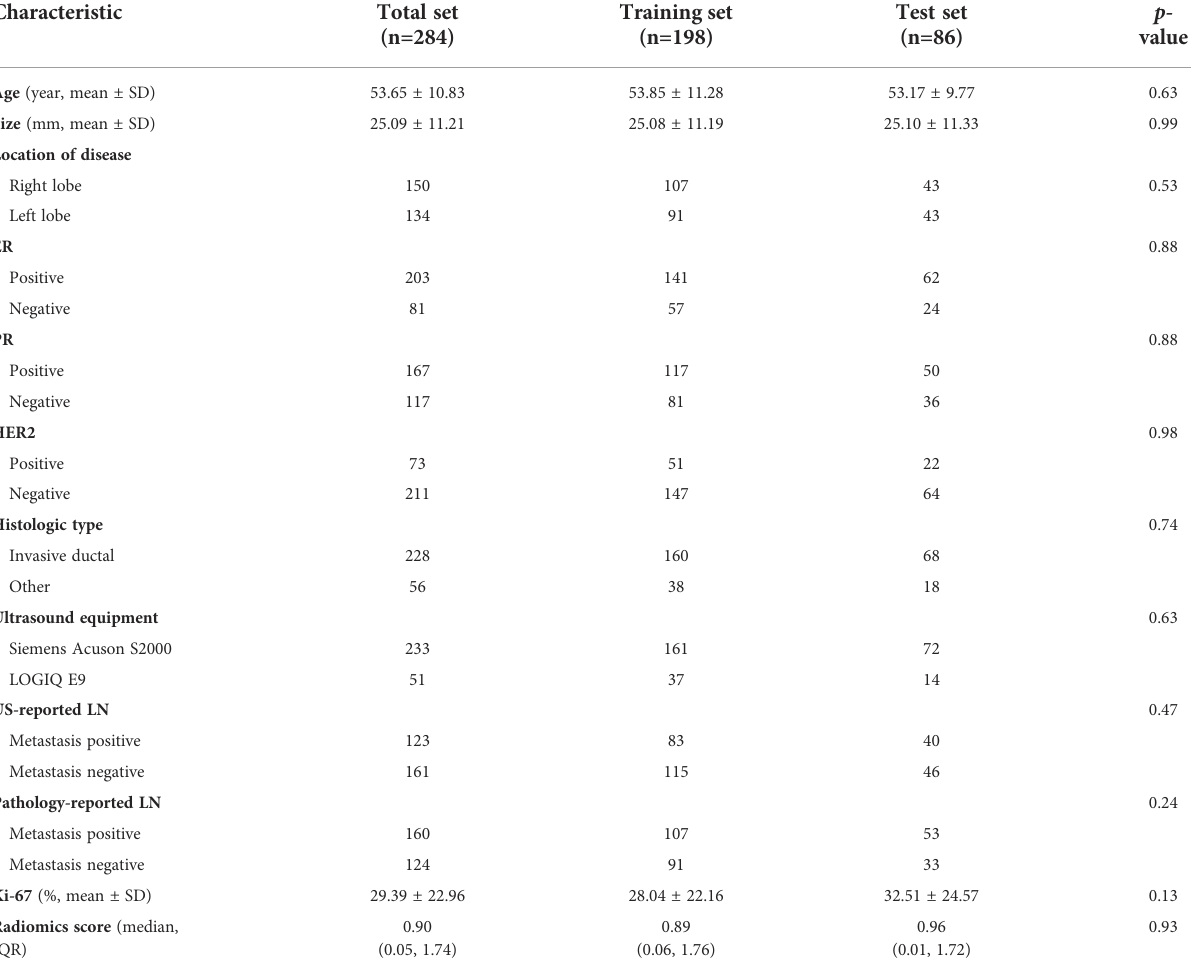
TABLE 1 The baseline characteristics of the enrolled patients in the training and test sets.